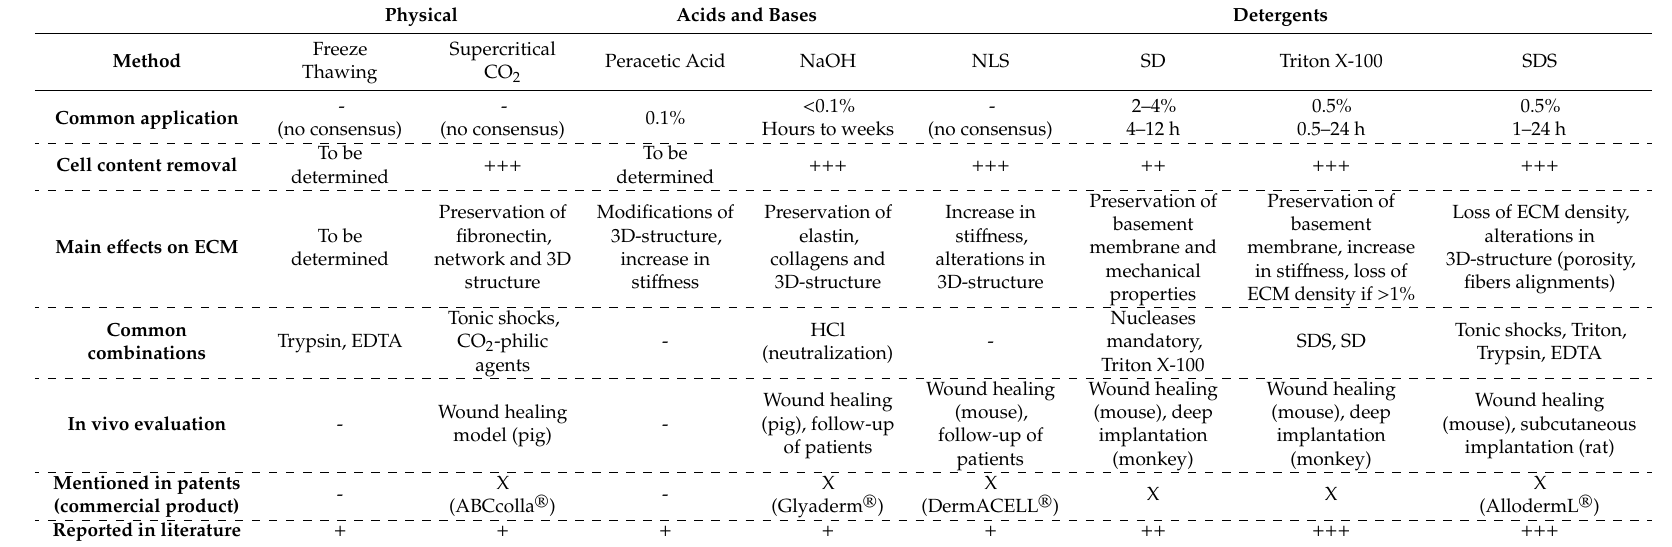
Table 2. Summary of the di ff erent main decellularizing agents and their